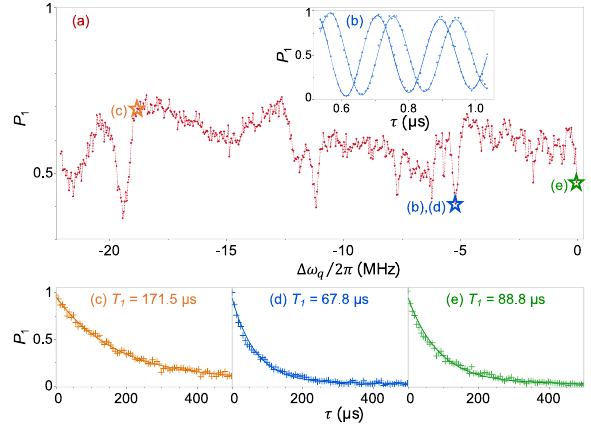
Fig. 3 Representative example of relaxation time dependence on frequency. a Measured probability of being in the 1 j i state, P 1 , at 50 μ s wait time with varying Δ ω q and tone detuned 50MHz above ω q /2 π for Q 19 . b Example of Ramsey measurements used to extract frequency shifts Δ ω q /2 π from pulse amplitudes. The two curves result from starting the Ramsey oscillations with a X π /2 or Y π /2 . c and d are T 1 measurement with Stark shifts Δ ω q /2 π = − 18.9 and − 5.3MHz, respec- tively. e T 1 measurement with no Stark shift (i.e., no Stark tone).